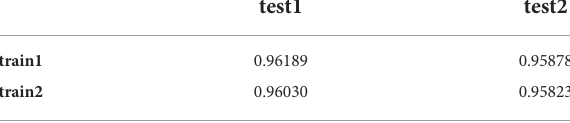
TABLE 3 R 2 score obtained from the trained models with both subsets of training and evaluated with both testing